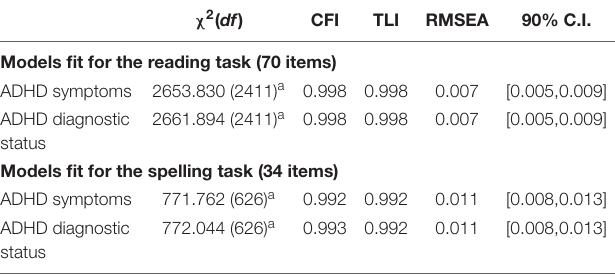
TABLE 4 | Model fit information for the MIMIC models for reading and spelling latent traits with ADHD symptoms (raw scores on DAWBA) and ADHD diagnostic status as